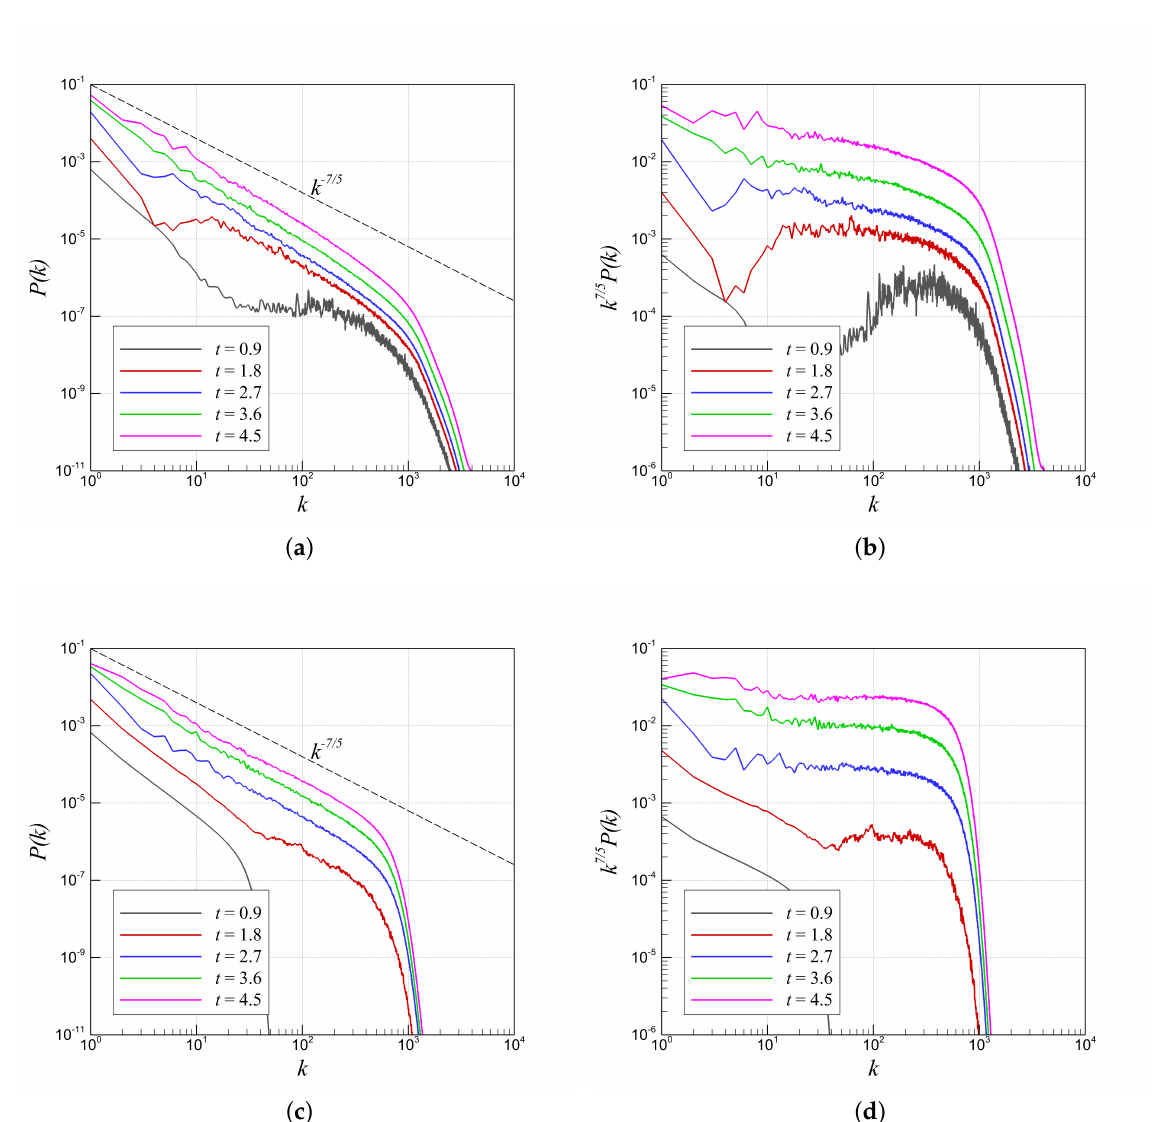
Figure 22. Time evolution of power density spectra and compensated power density spectra for the RTI problem with single-mode perturbation obtained using different modeling approaches at a resolution of 8192 × 24576; ( a ) power density spectra using ILES-Roe solver; ( b ) compensated power density spectra using ILES-Roe solver; ( c ) power density spectra using CS+RF ( σ = 1.0) solver; ( d ) compensated power density spectra using CS+RF ( σ = 1.0)